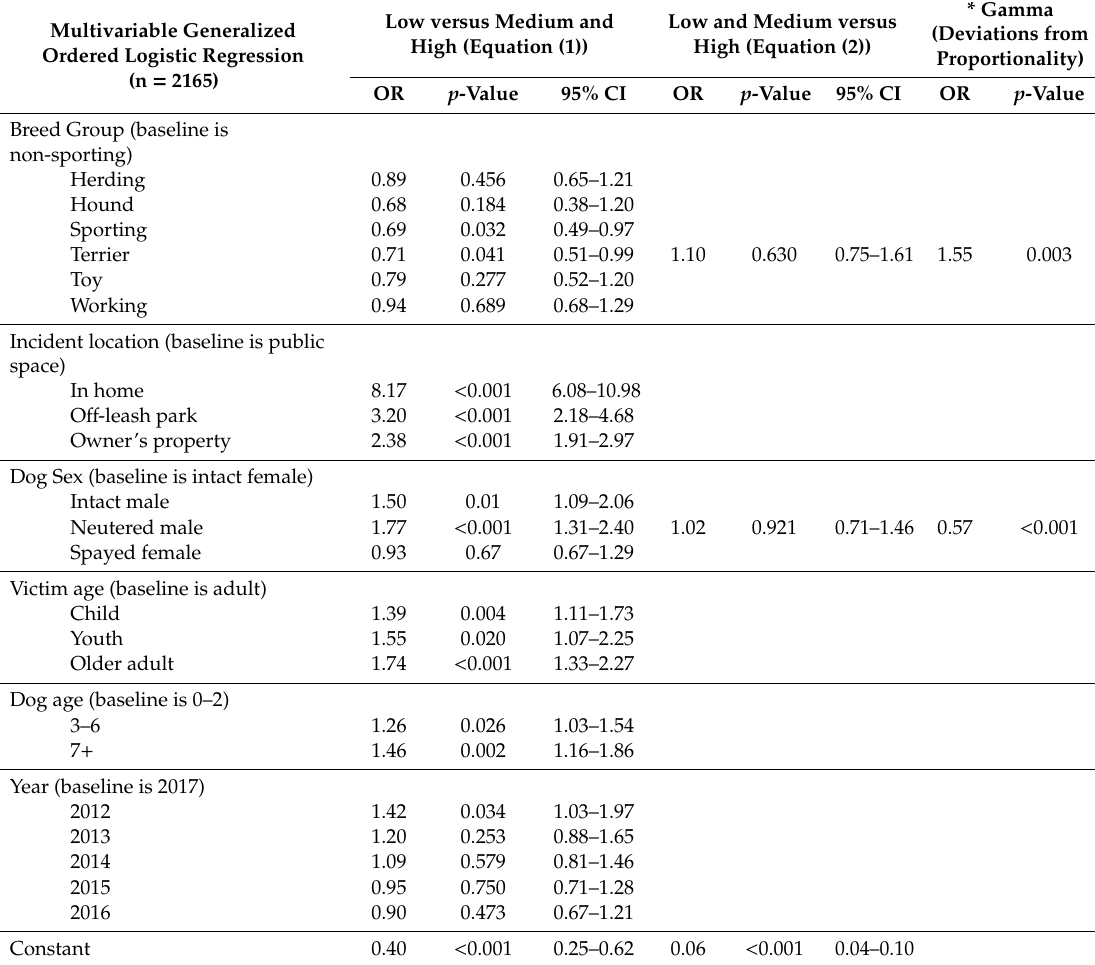
Table 3. Multivariable generalized ordered logistic regression